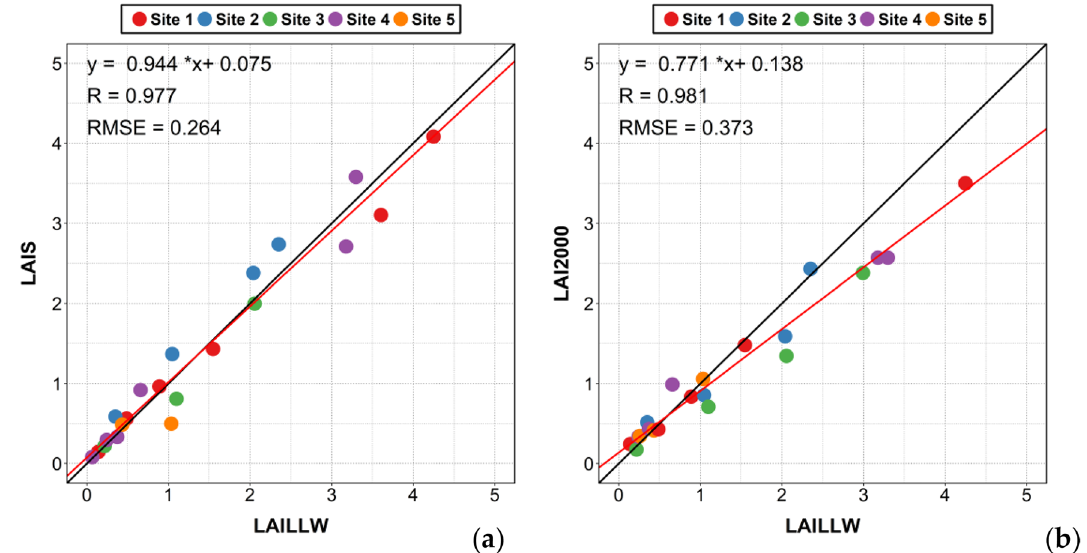
Figure 8. Scatter distribution of the LAI estimation: ( a ) the LAIS; ( b ) the LAI2000.